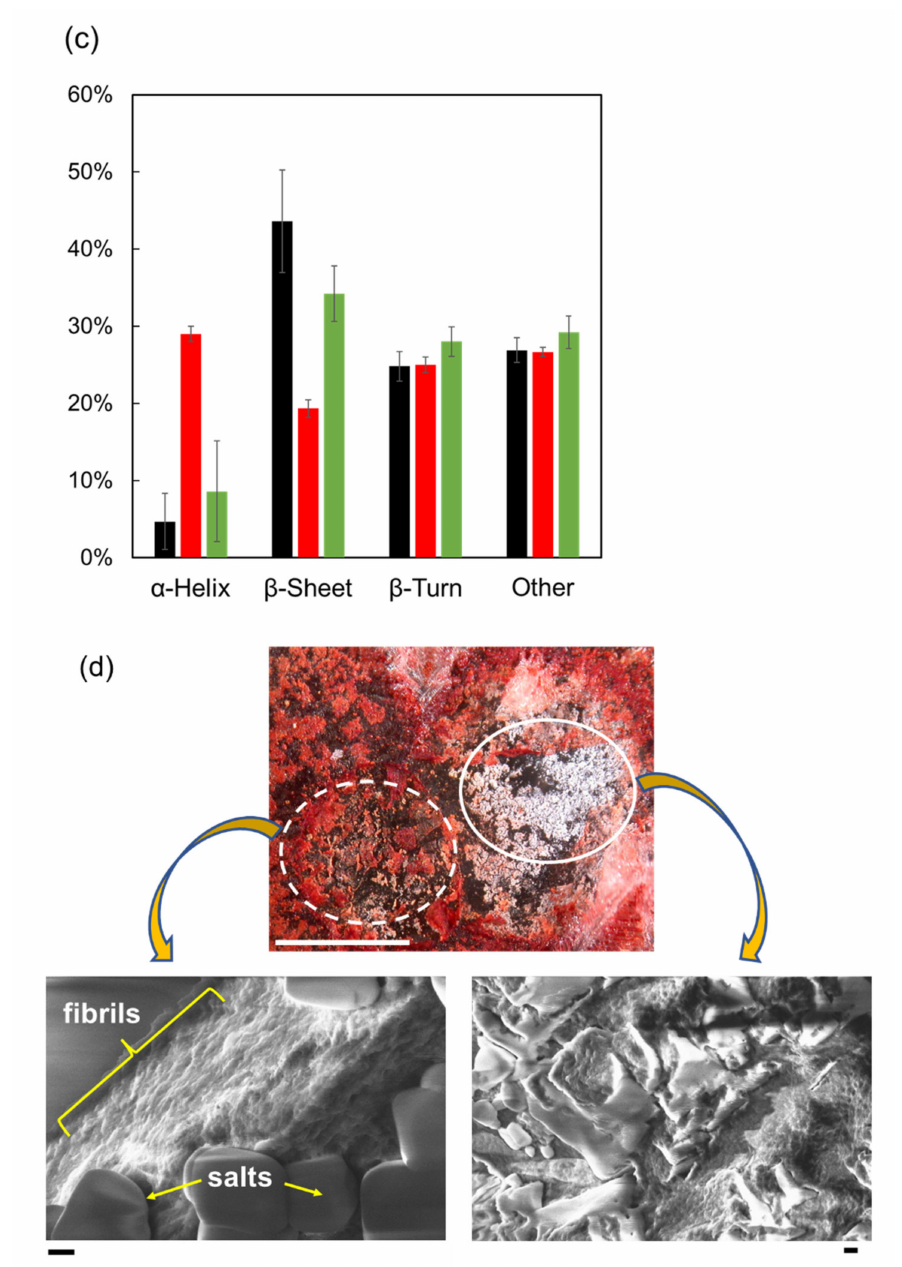
Figure 2. Irradiation Effect of THz-FEL on lysozyme fibril. ( a ) Far-infrared spectrum. ( b ) Mid-infrared spectra. Black: non-irradiation; red: irradiation at 56 µ m; green: irradiation at 70 µ m. ( c ) Protein secondary conformations before and after irradiation. The color category is the same as ( b ). ( d ) Congo red staining (upper) and SEM observation (below). Irradiation area is shown as a white solid circle and non-irradiation area is indicated by a white dotted circle. White scale bar: 500 µ m; black scale bar: 200